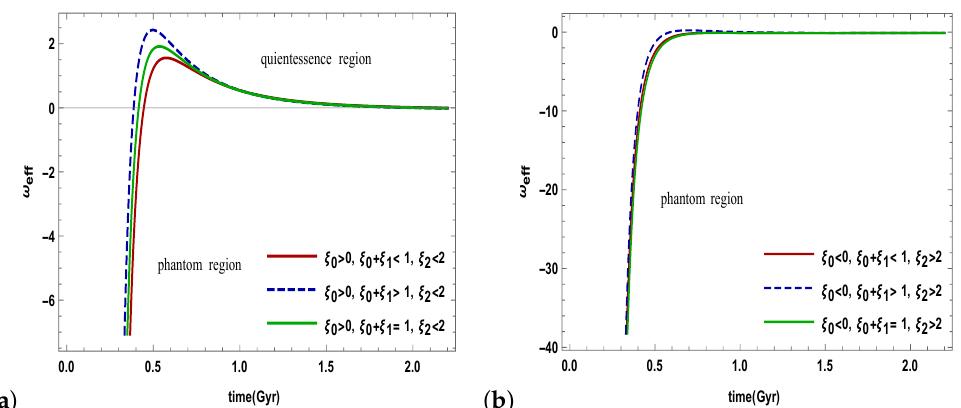
Figure 3. The variation of EoS parameter versus time t for various limiting conditions of the bulk viscosity coefficients. ( a ) ξ 0 > 0; ( b ) ξ 0 < 0. Table 2. Existence of different substances according to EoS parameter. Substance Observation EoS Parameter Lead to Big Rip, resist to weak ω < − 1 Phantom Universe (Ph) energy condition Quintessence (Q) 68% of the universe ω T ∈ ( − 1/3, − 1 ) Cosmological constant Inconsistent with observation ω T = − 1 Hard Universe (HU) high densities ω T ∈ ( 1/3,1 ) Influential in past